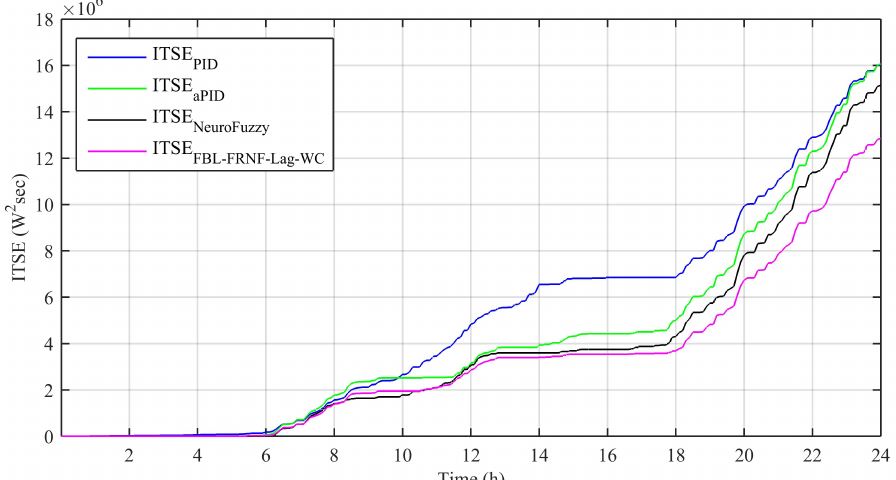
Figure 13. Integral time-weighted squared error (ITSE)